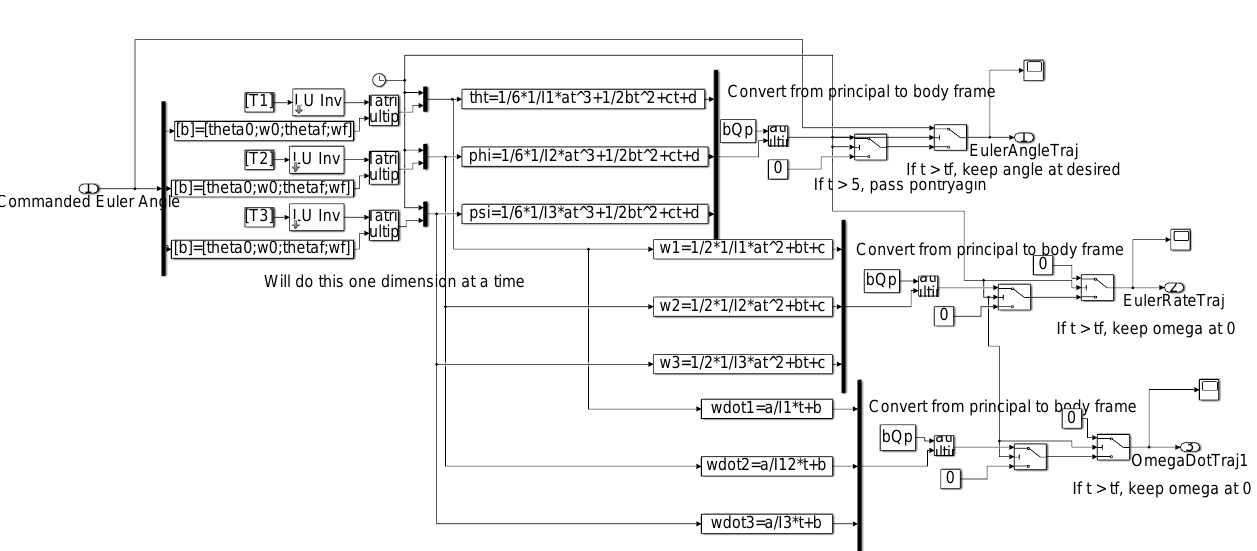
Figure A3. Sinusoidal Trajectory Generation.